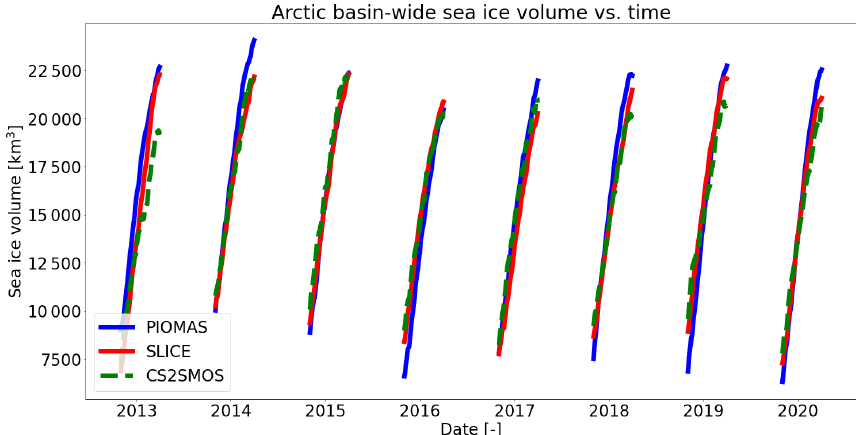
Figure 9. Wintertime sea ice volume versus time for SLICE, PIOMAS, and AWI